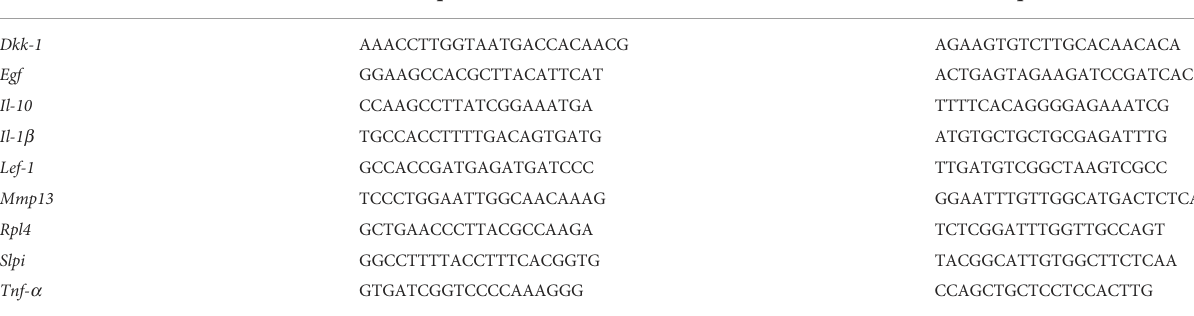
TABLE 1 Primer used for